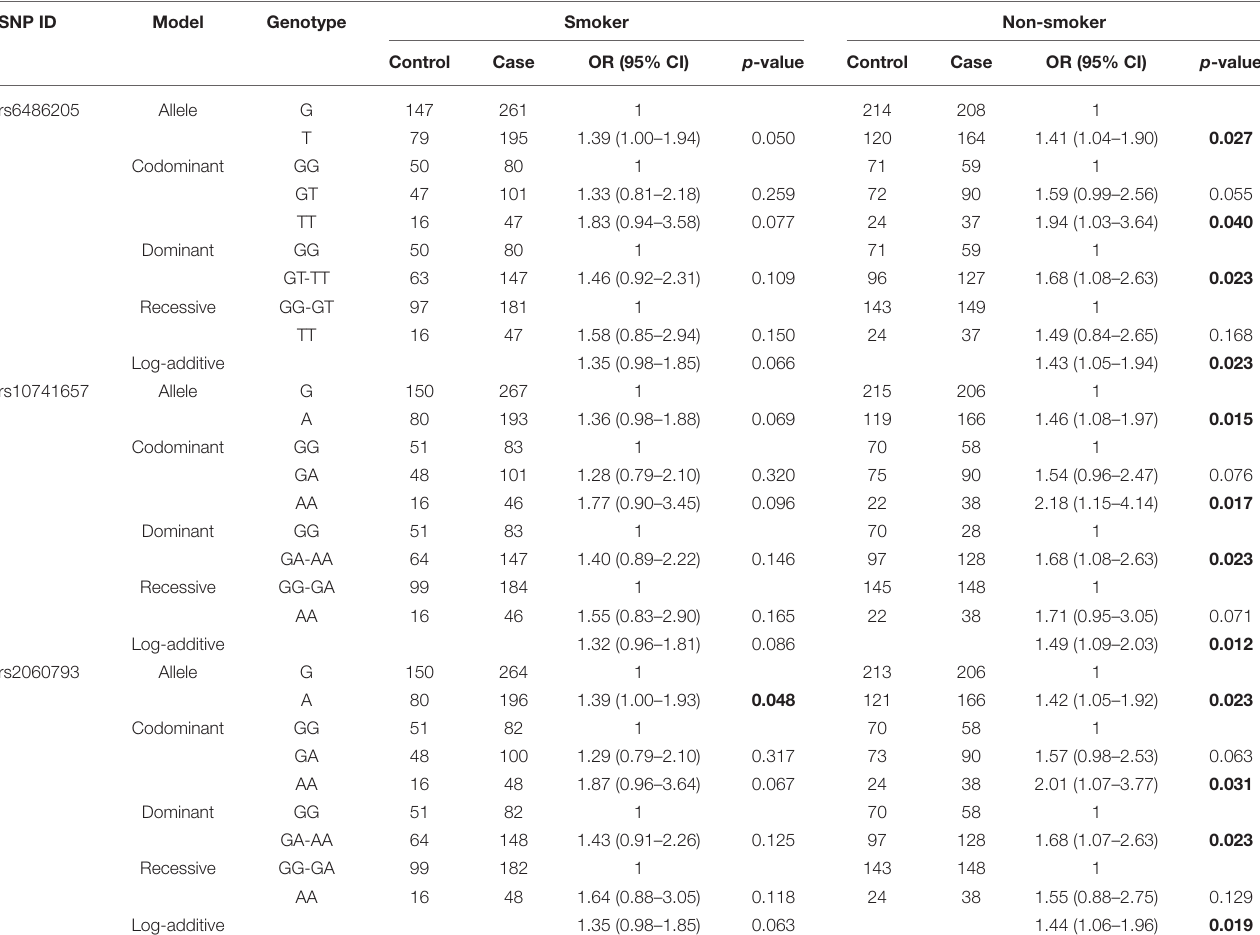
TABLE 5 | Association between CYP2R1 polymorphisms and CHD risk according to stratification by